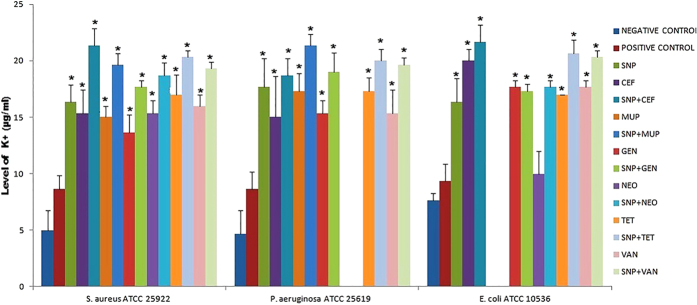
Comparative measurement of intracellular potassium release.Values are expressed as means (n = 3), and error bars represent standard deviations. Asterisks (*) indicate a statistical significant difference (P < 0.05) between the negative control and the treatments.